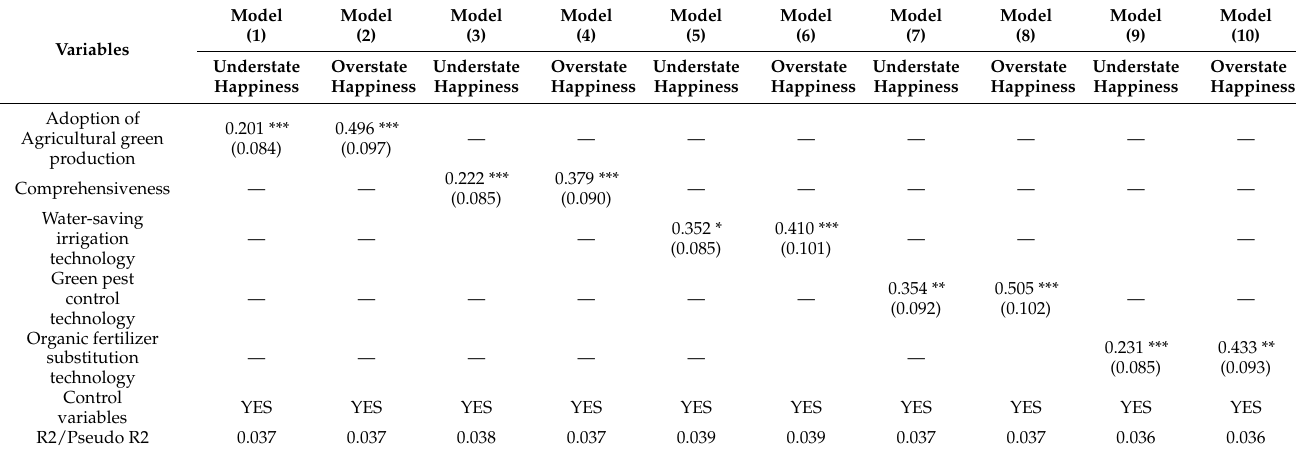
Table 5. Robustness testing results after replacing the explained variable assignment.